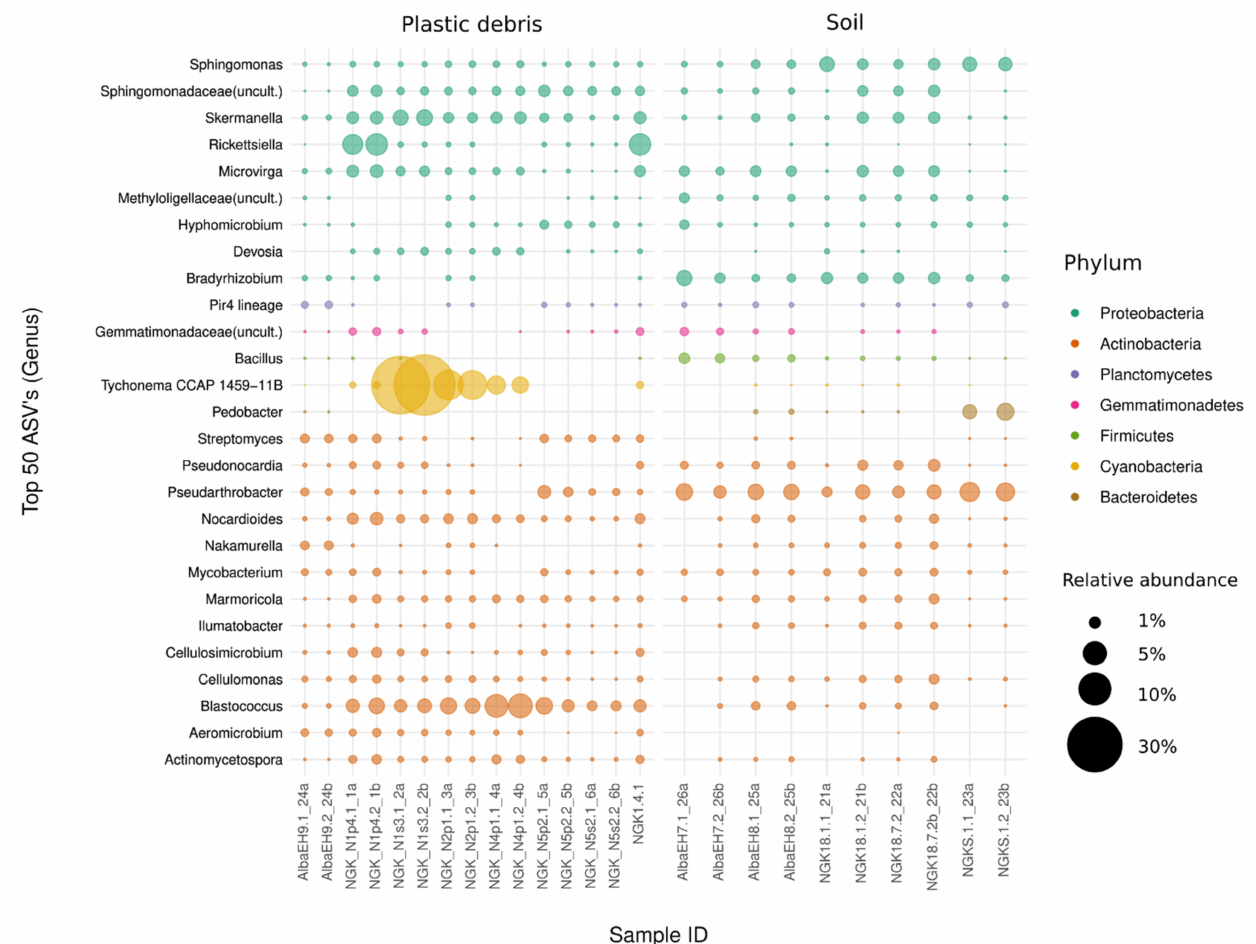
Figure 3. Bubble plot of the top 50 most abundant bacterial ASVs and their corresponding genus present in plastic debris and reference soil (soil). Colors indicate the corresponding phylum of the listed taxa. The size of the bubbles represents their relative